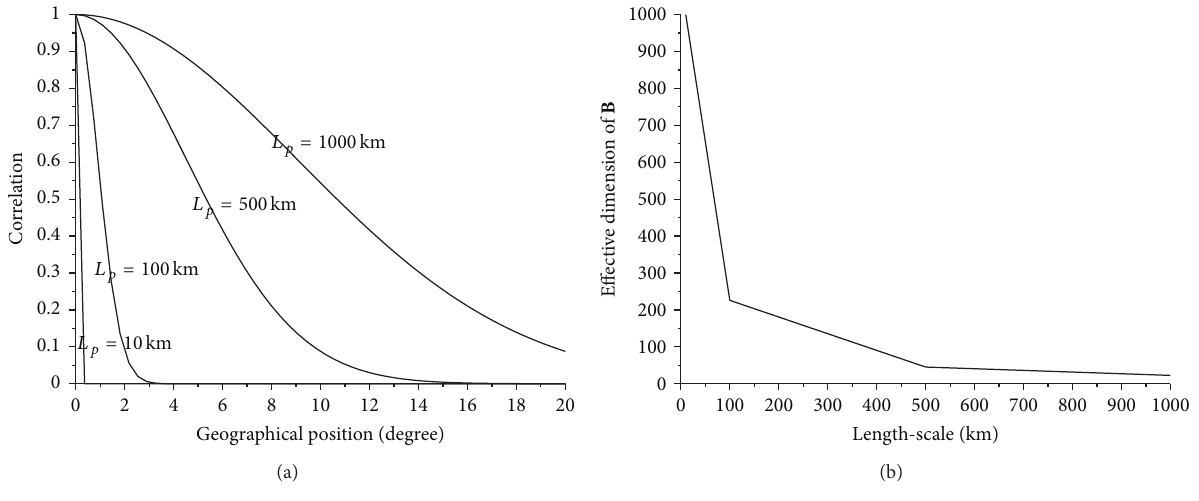
Figure 3: Correlation function (a) and effective dimension 𝑑 ef ( B ) = tr ( B ) 2 / tr ( B 2 ) (b) for increasing length-scale parameter 𝐿 𝑝 ∈ {10, 100, 500, 1000} km, for the dimension set to 𝑛 = 1000